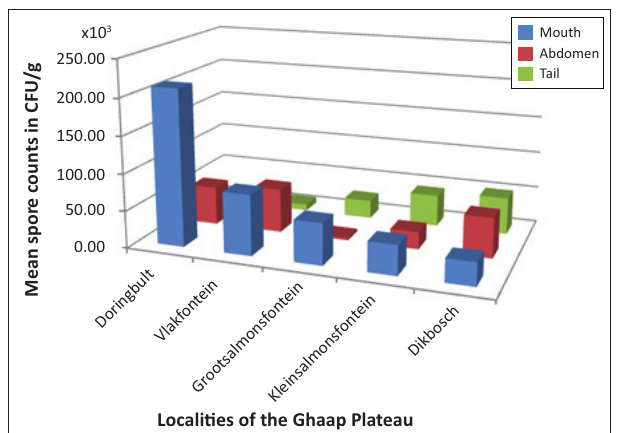
Source : Generated in Google earth V 6.2.2.6613 (http://www.earth.google.com) using data collected during this study FIGURE 1-A1: A closer view of water drainage on Doringbult and Honey’s Corner farms in the Ghaap Plateau in the Northern Cape province. The water runoff moves towards Doringbult and thereafter to Honey’s corner farm where mass alluvial deposition occurs (white